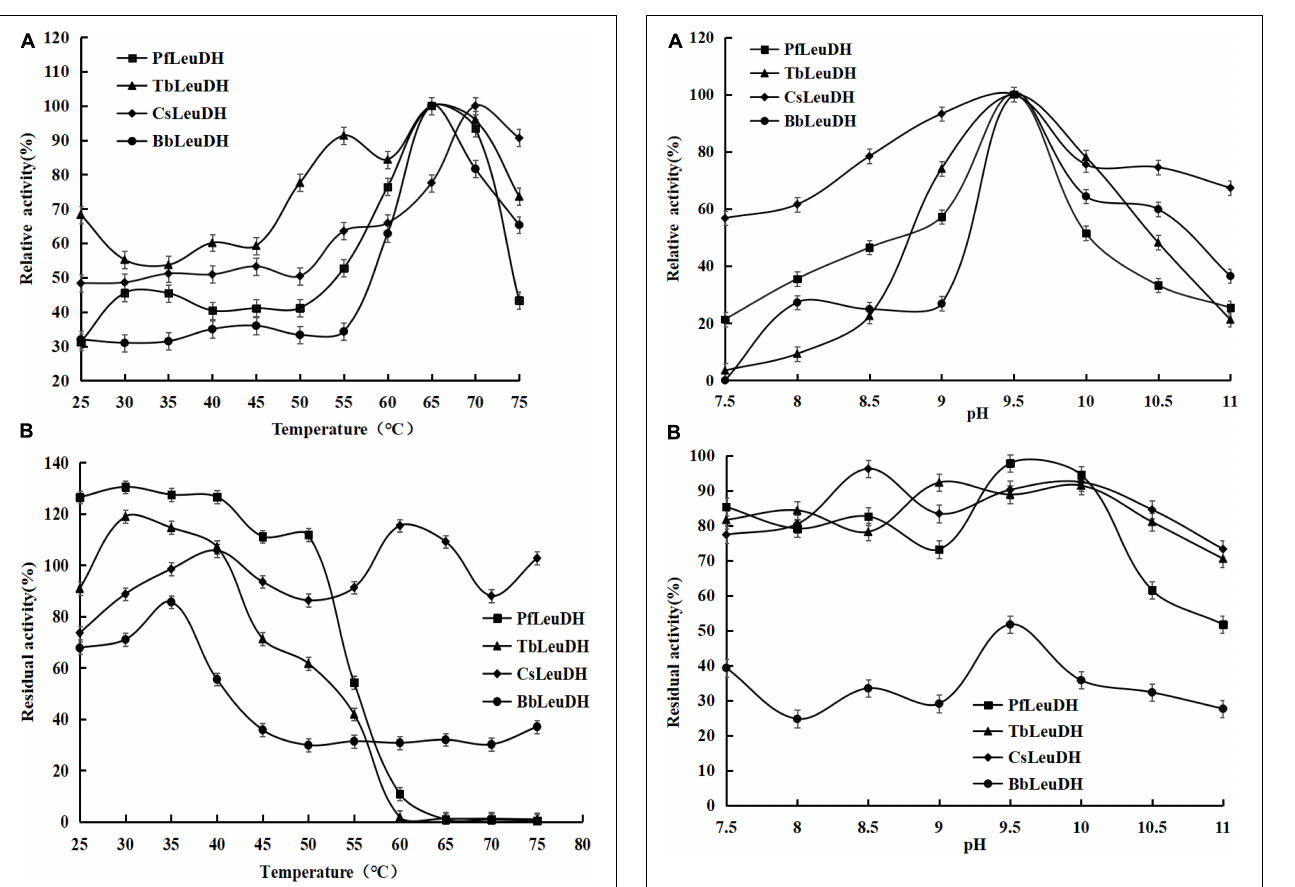
FIGURE 4 | The pH properties of the representative recombinant leucine dehydrogenases. (A) pH optima of the representative recombinant leucine dehydrogenases. The pH optima were assayed by the standard activity assay method as described in the text with 500 mM NH 4 Cl-NH 3 · H 2 O buffer over the pH range of 7.5-11.0. (B) pH stabilities of the representative recombinant leucine dehydrogenases. To estimate the pH stability, aliquots of these recombinant leucine dehydrogenase solutions were preincubated at 0 ◦ C for 1.0 h at various pH values from 7.5 to 11.0, and the residual activities were assayed under the optimal reaction temperatures and pH